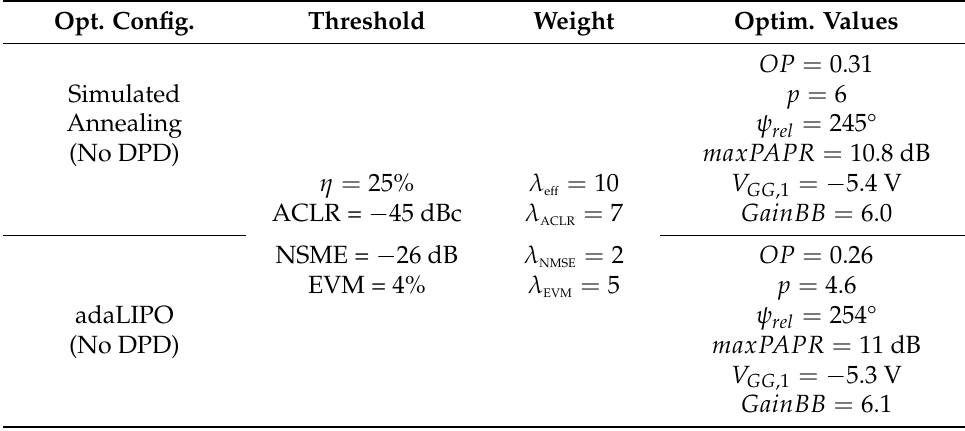
Table 1. Parameters configuration for a LTE 20 MHz bandwidth signal. Opt.